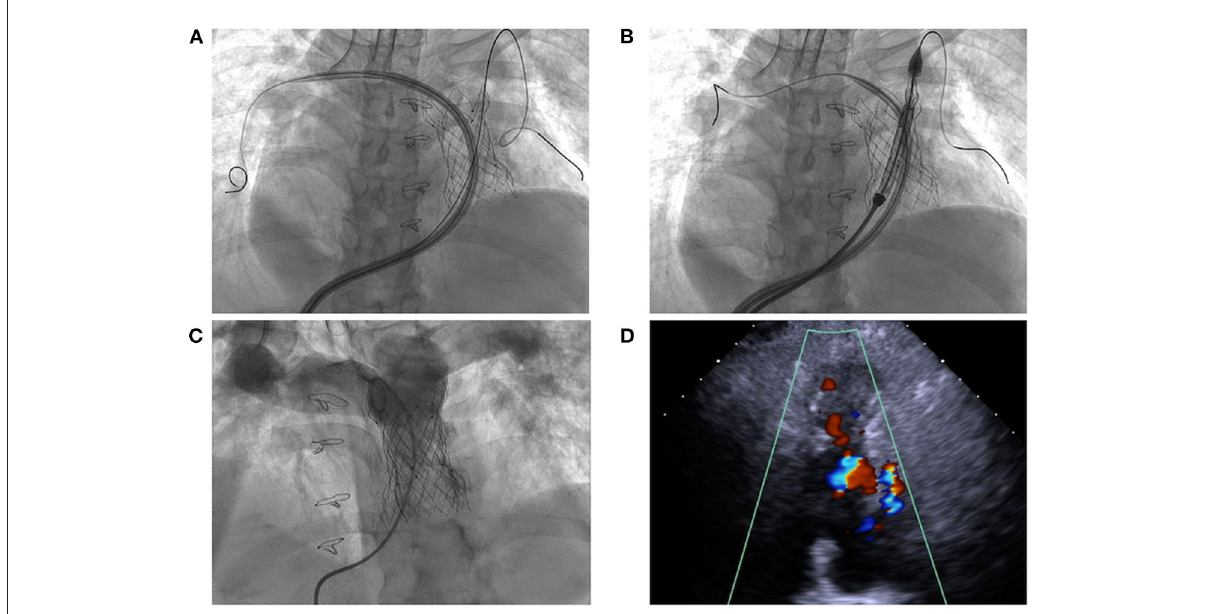
FIGURE2 Transcatheter pulmonary valve-in-valve implantation for degenerated bioprosthesis. (A,B) The delivery system crossed the degenerated bioprostheses with the assistance of modified buddy wire; (C,D) The result of transcatheter valve-in-valve implantation with no pulmonary regurgitation.